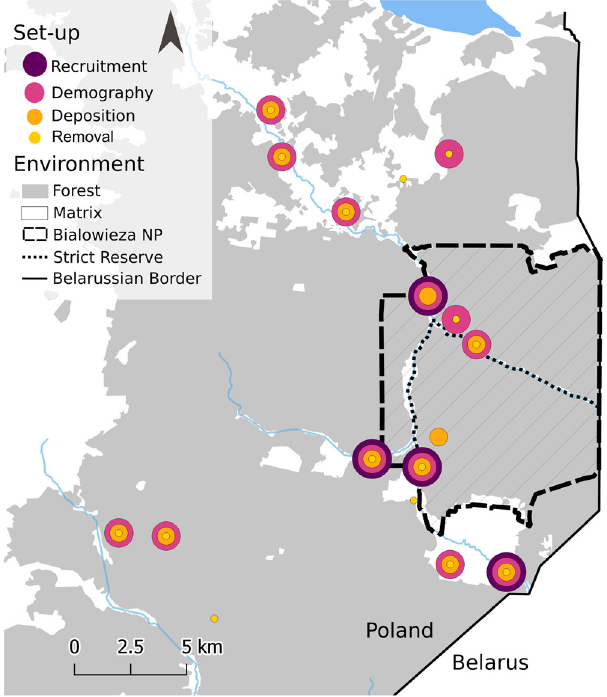
Fig. 5 Study area and sites. Map showing the location of the 17 study sites in the Bia ł owie ż a Forest, Eastern Poland, and the studies conducted at these locations. The map was based on OpenStreetMap 113 and created using QGIS 114